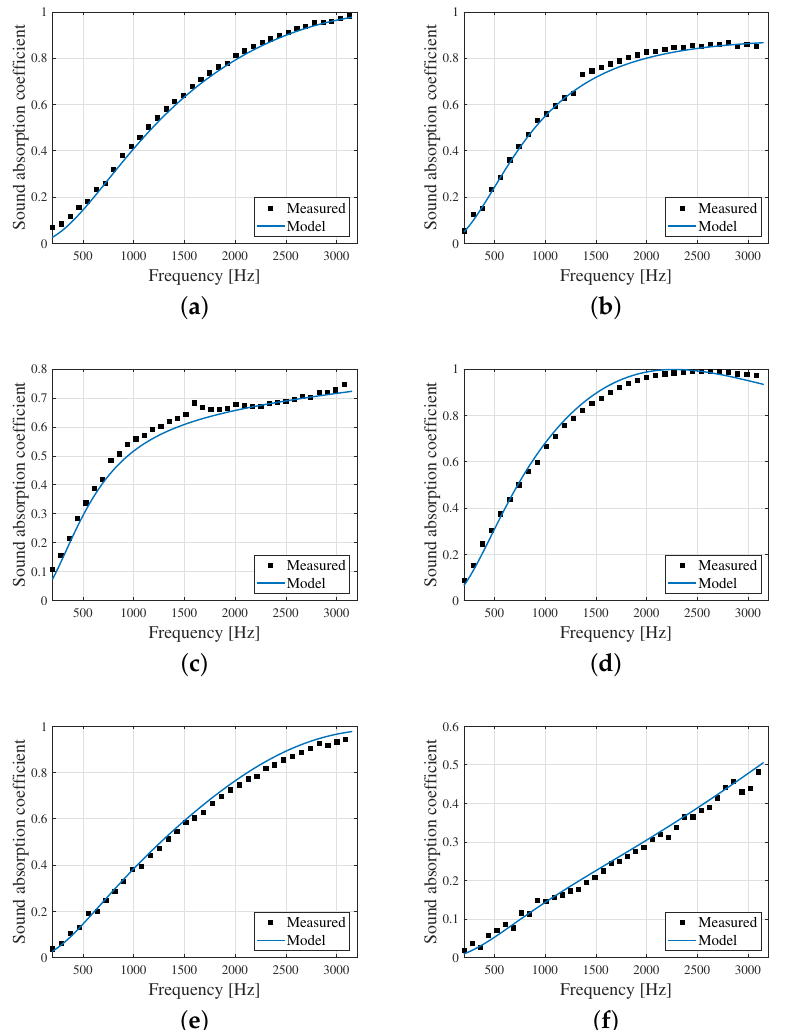
Figure 7. Comparison of the measured sound absorption coefficient and theoretical one calculated by six non-acoustical parameters based on the JCAL model for six sintered felt samples, ( a ) Sample 1, ( b ) Sample 2, ( c ) Sample 3, ( d ) Sample 4, ( e ) Sample 5, ( f ) Sample